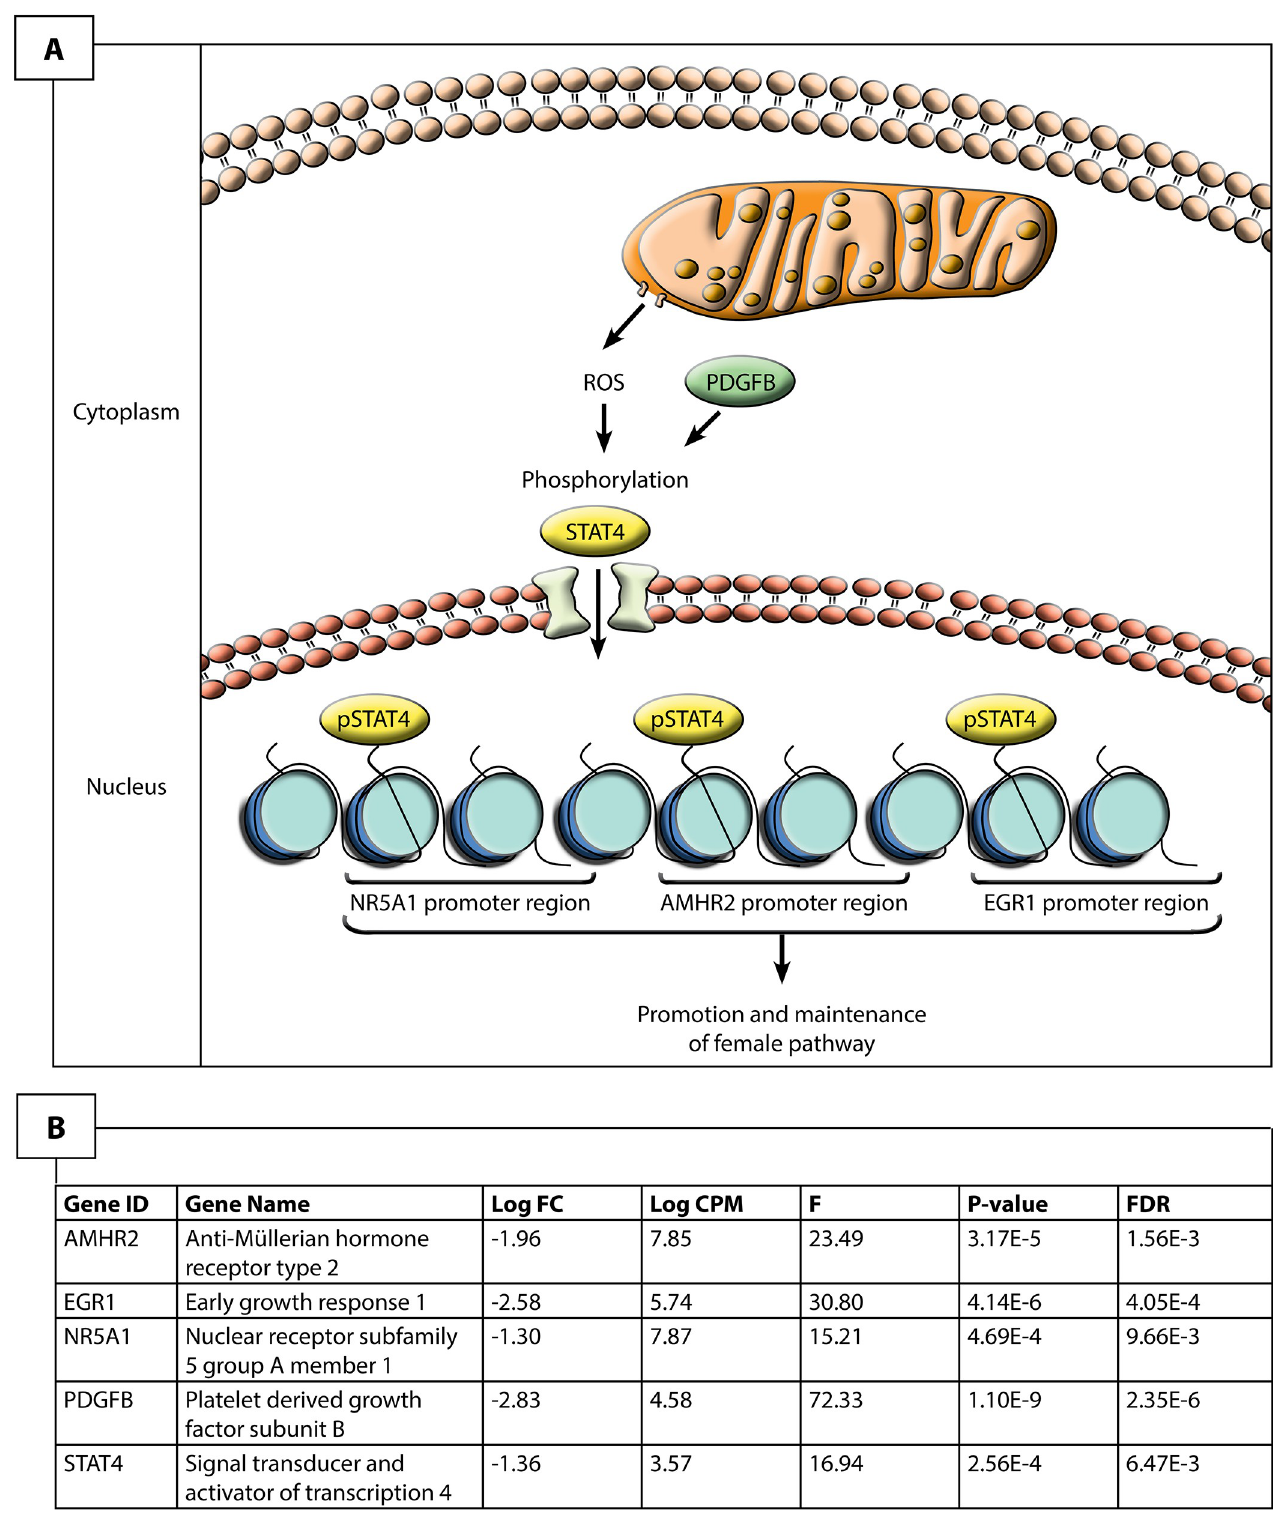
Fig 4. Hypothesized pathway for the maintenance of the ovarian phenotype in stage 12 sex reversed ZZf Pogona vitticeps . Given the upregulation of these genes, it is likely that reactive oxygen species induce the phosphorylation, and subsequent activation and nuclear translocation of STAT4, likely mediated by PDGFB. Once in the nucleus, STAT4 is able to bind to promoter regions of known target genes, NR5A1 , AMHR2 and EGR2 to regulate their expression and promote ovarian development. https://doi.org/10.1371/journal.pgen.1009465.g004 PLOS Genetics | https://doi.org/10.1371/journal.pgen.1009465 April 15,